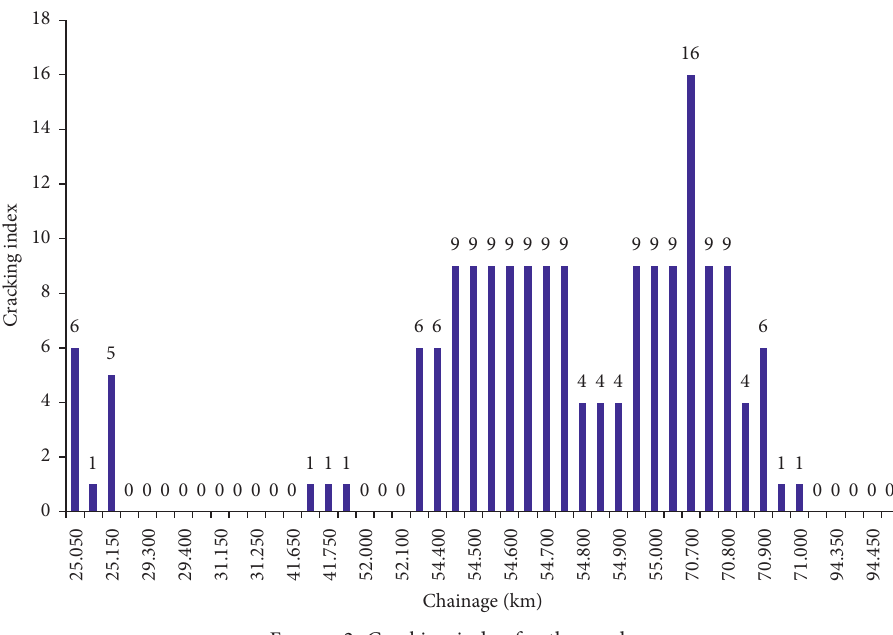
Figure 2: Cracking index for the